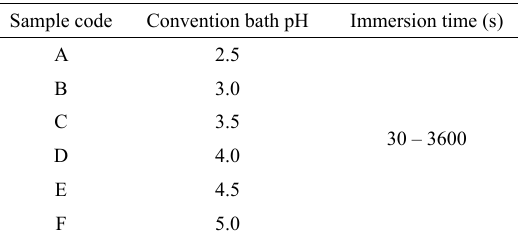
Table 2. Sample codes and parameters evaluated in this study. Sample